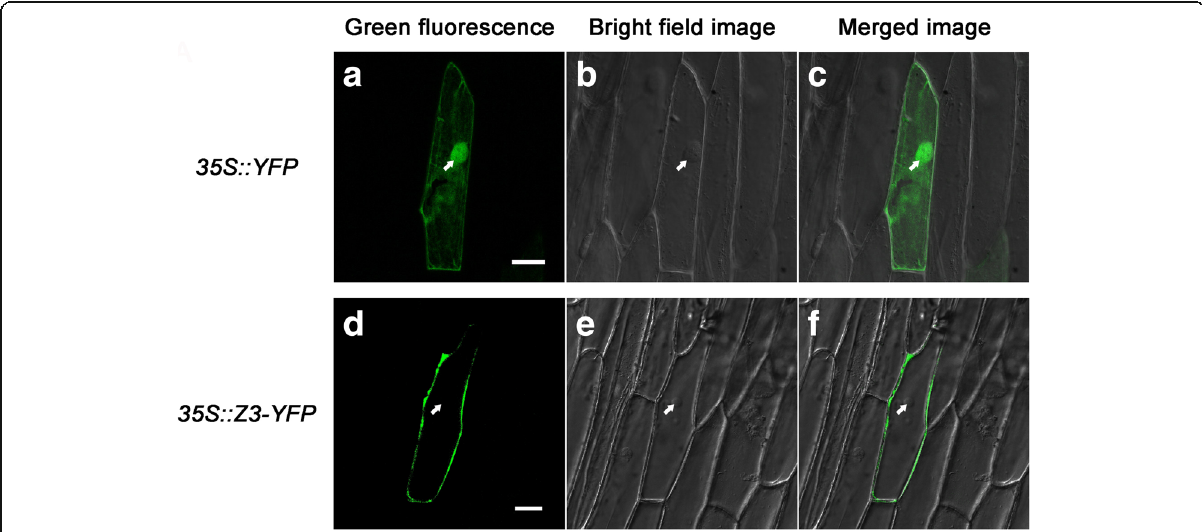
Fig. 4 Z3 localizes in the plasma membrane. a – c Onion epidermal cells transformed with the control construct ( 35S::YFP ). d – f Onion epidermal cells transformed with the construct 35S::Z3-YFP . a, d Green fluorescence; b, e bright field image; c, f merged image. Cells were analyzed by confocal microscopy 18 h after the particle bombardment. Arrows indicate the nucleus. Scale bars = 50 μ